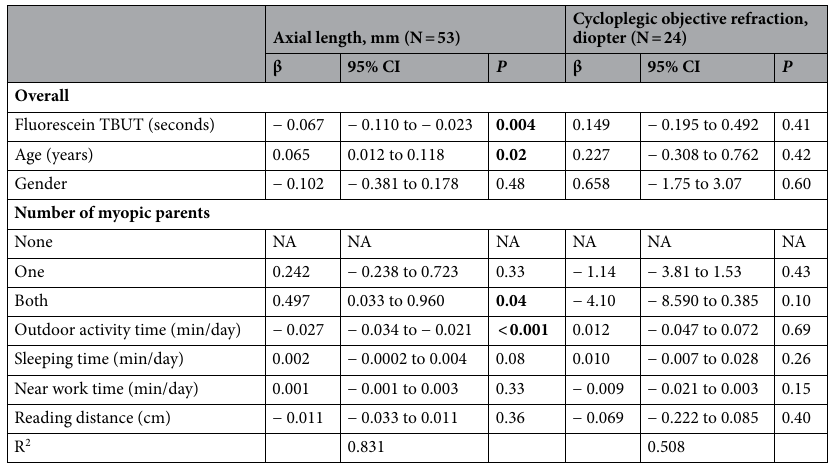
Table 2. Results of multiple regression analyses to estimate the association between myopia and environmental factors. Two multiple regression models were used. Axial length or cycloplegic objective refraction was used as the outcome variable. P values less than statistically significant level (< 0.05) are marked in bold. For gender, boys were numbered 1 and girls were numbered 0. β coefficient, 95% CI 95% confidence interval, TBUT tear film breakup time, NA not applicable.